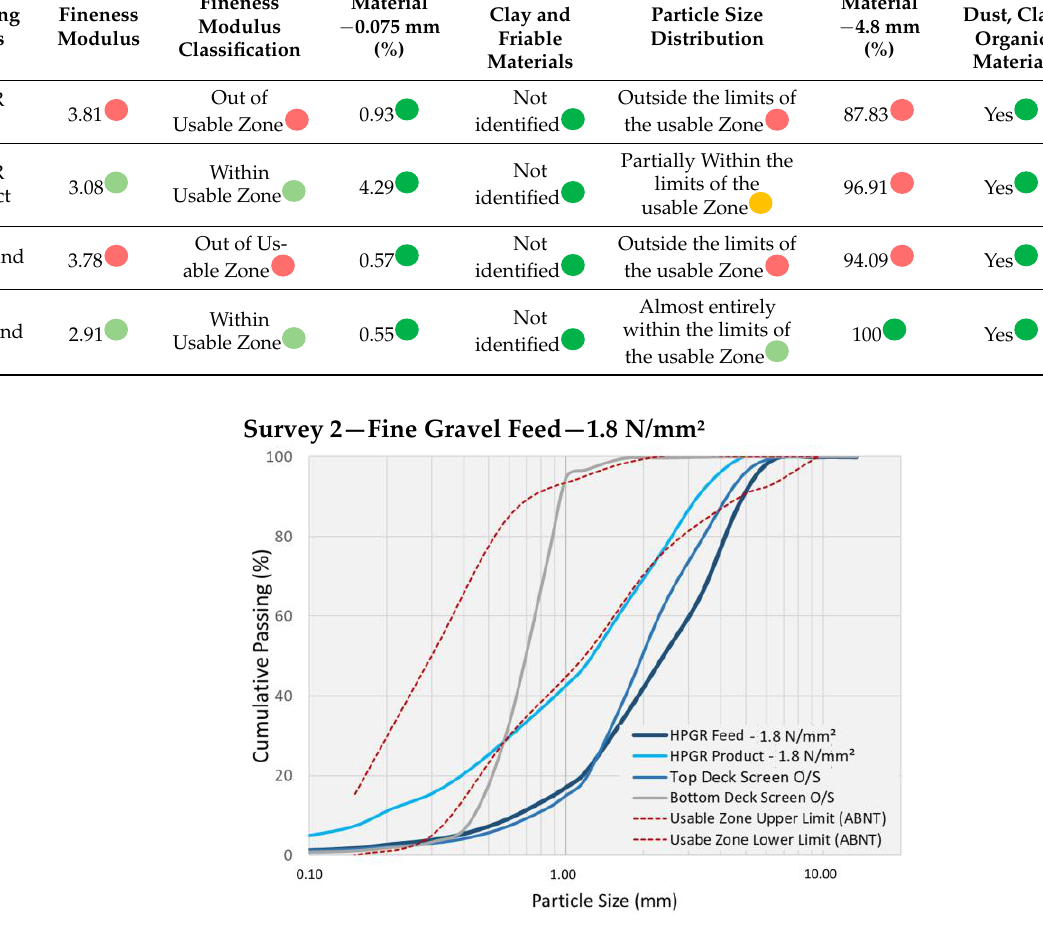
Figure 9. Survey 2 size distributions and limits for use as sand for concrete. Table 9. Survey 2 product